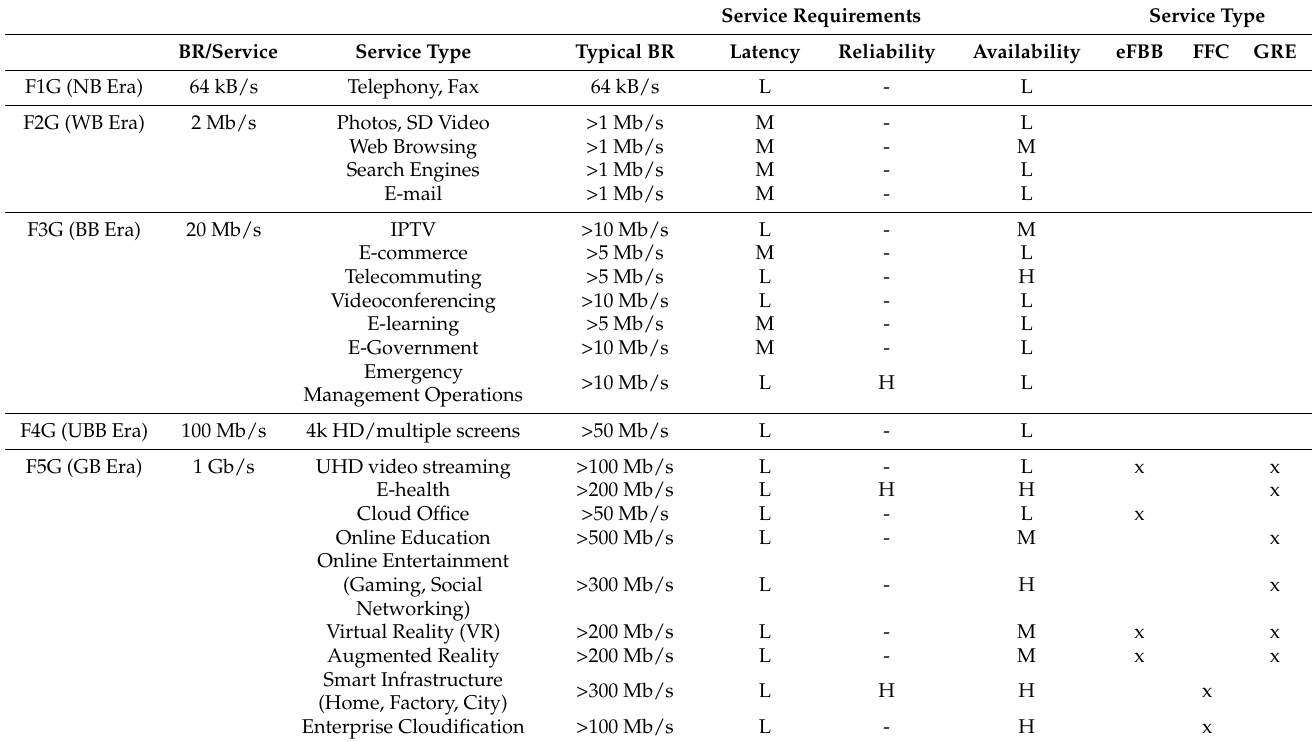
Table 1. Classification of services and their requirements using the F1G-F5G scheme. eFBB: